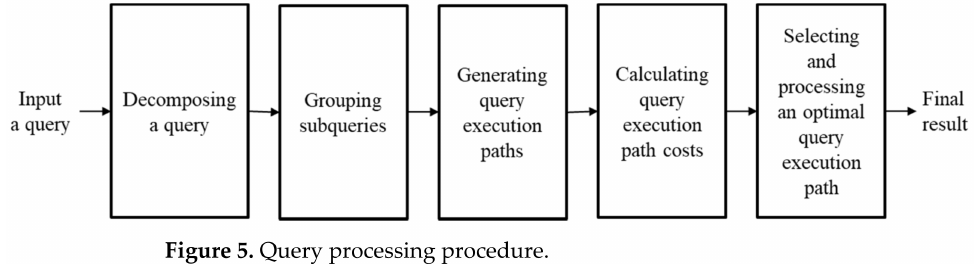
Figure 5. Query processing